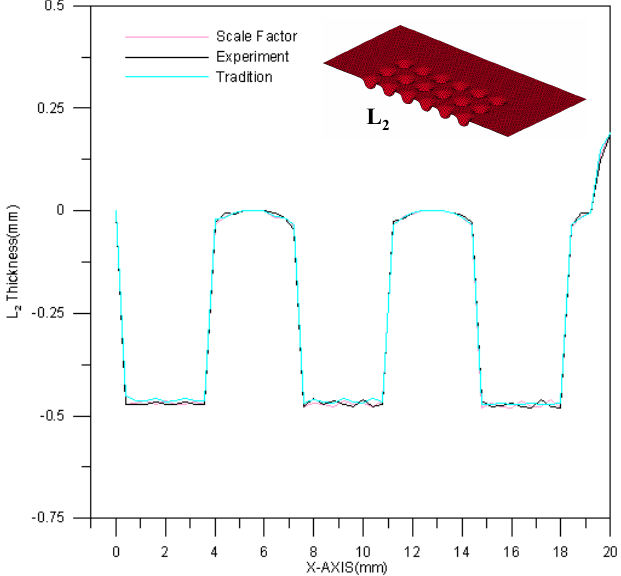
Figure 12. The contour comparison of L 2 section.